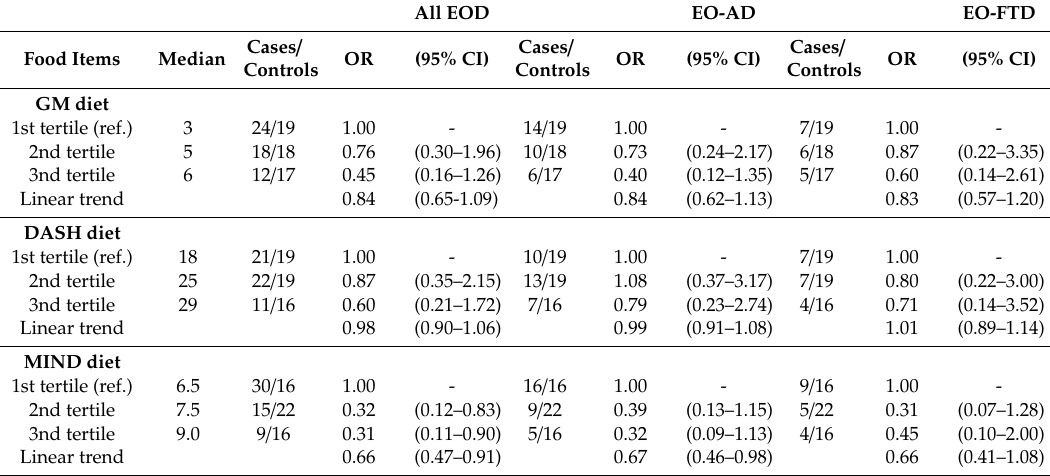
Table 3. Odds ratio (OR) and 95% confidence intervals (CI) of early-onset dementia (EOD), early-onset Alzheimer’s dementia (EO-AD), and early-onset frontotemporal dementia spectrum (EO-FTD) for increasing tertiles of adherence to dietary patterns. Greek-Mediterranean (GM) diet, Dietary Approaches to Stop Hypertension (DASH) diet, and Mediterranean-DASH Intervention for Neurodegenerative Delay (MIND) diet. A linear trend for 1-unit increase is reported. All EOD EO-AD